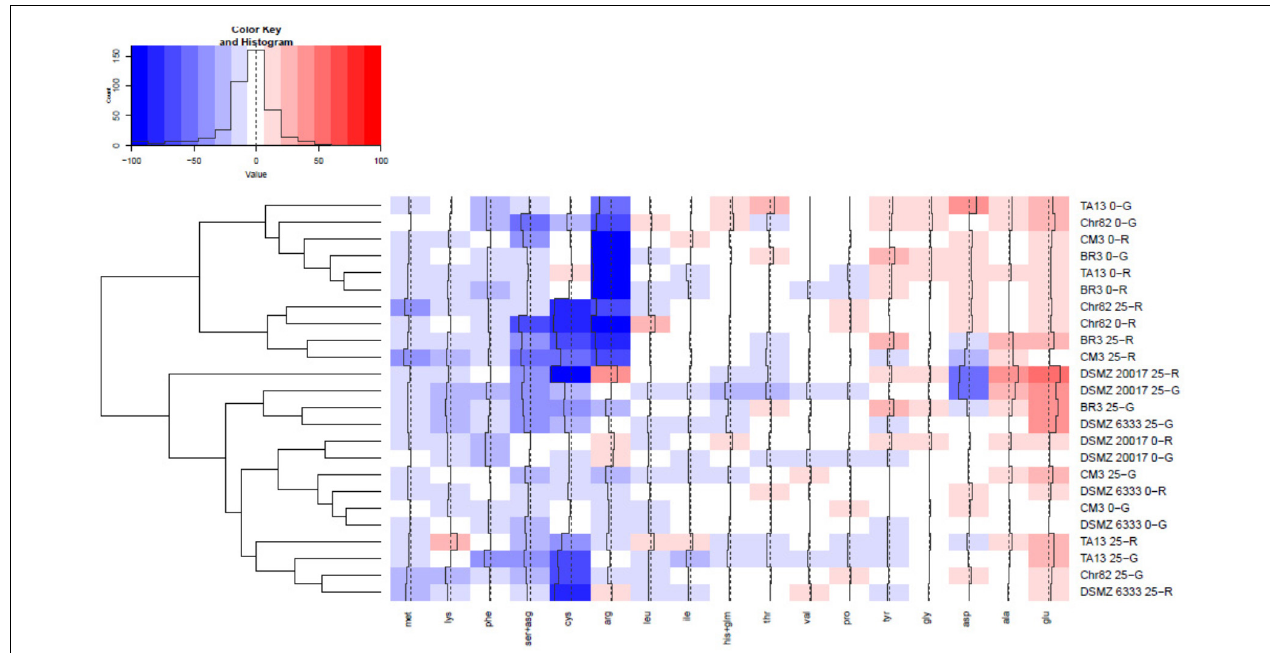
FIGURE 4 | Heatmap relative to amino acid presence after 24 h of incubation. The quantitative change of each amino acid is expressed as percentage variation with respect to the initial concentration in DM (reported in Table 1 ). Increasing red intensity indicates increasing accumulation, whereas increasing blue intensity indicates increasing consumption. The dendrogram represents the hierarchical clustering process performed on the amino acid variations. A complete linkage approach on the Euclidean distance matrix was